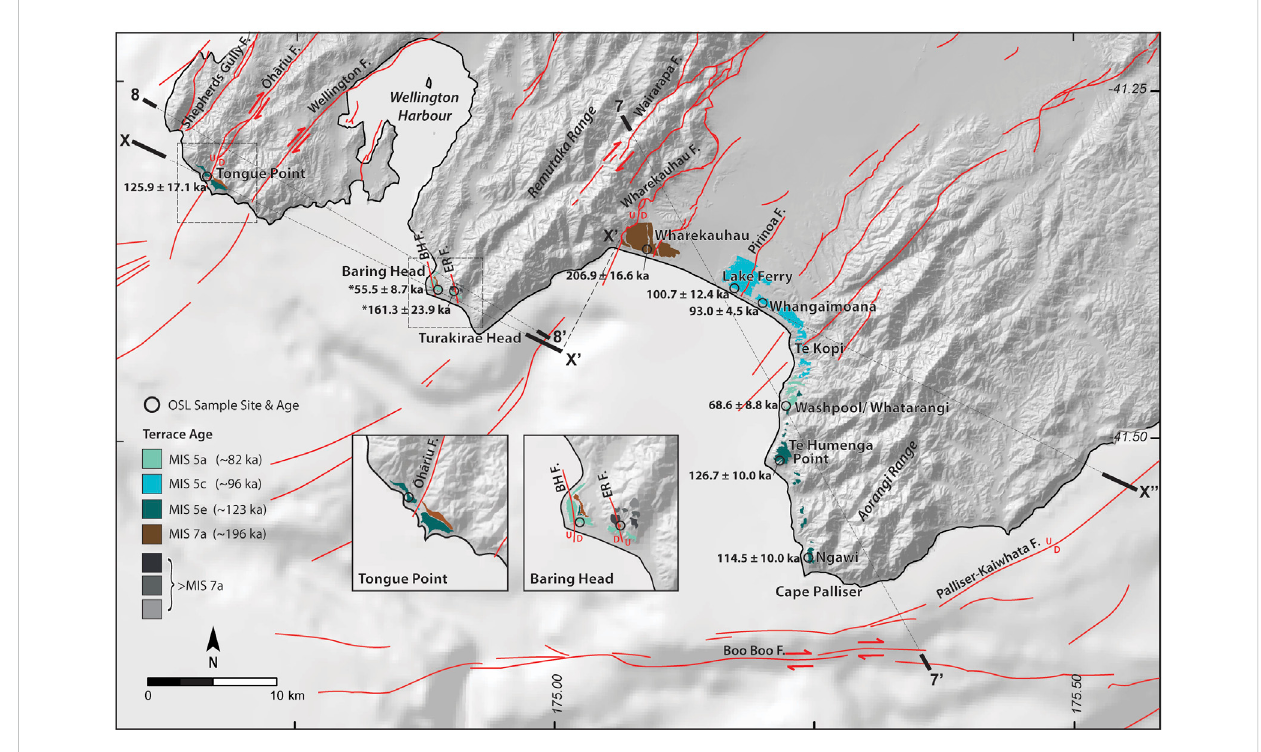
FIGURE 2 Late Pleistocene marine terrace MIS ages and distribution along the Wellington south coast, including OSL sample collection sites (black open circles) and corresponding ages (asterisks denotes minimum age) — only ages relevant to dating the shore platform are shown; MIS and OSL ages from Ninisetal. (2022).Alsoshownareactive crustalfaults(redlines) (onshore faultsfromtheNewZealandCommunityFaultModel(NZCFM)-Seebecketal., 2022;offshorefaultsfromBarnesetal.,2008)(BHF,BaringHeadFault;ERF,EastRiverFault).Locationofpro fi lesforFigure7,Figure8andPro fi leXof Figure 6, Figure 9 are shown. Figure modi fi ed from Ninis et al.,